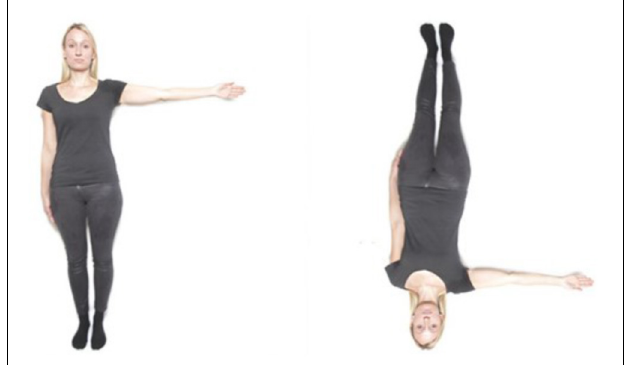
FIGURE 1 | Example of the stimuli used for the different conditions. Object-based transformation of a female stimulus in front view condition (disparity of 180 ◦ ). Written informed consent was obtained for the publication of this image (Kaltner and Jansen, 2018).